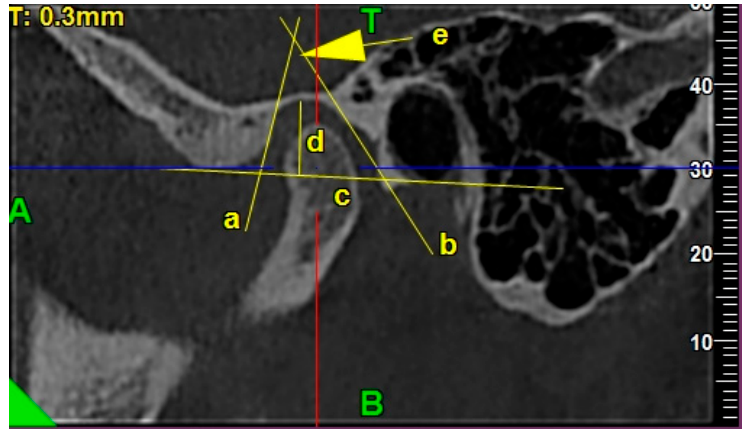
Figure 3. The exemplary lines, points, and angles in the TMJ CBCT scans used for measurements regarding the morphology of the glenoid fossa in the sagittal view: /a/ PE line, /b/ AT line, /c/ glenoid